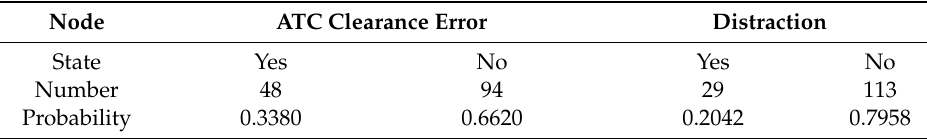
Table 2. Marginal probabilities for nodes ATC clearance error and distraction.